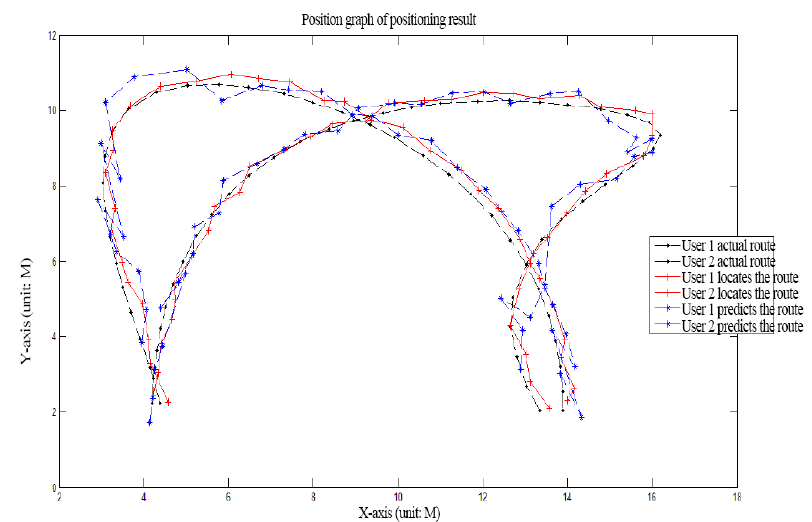
Figure 12. Users’ positioning results.